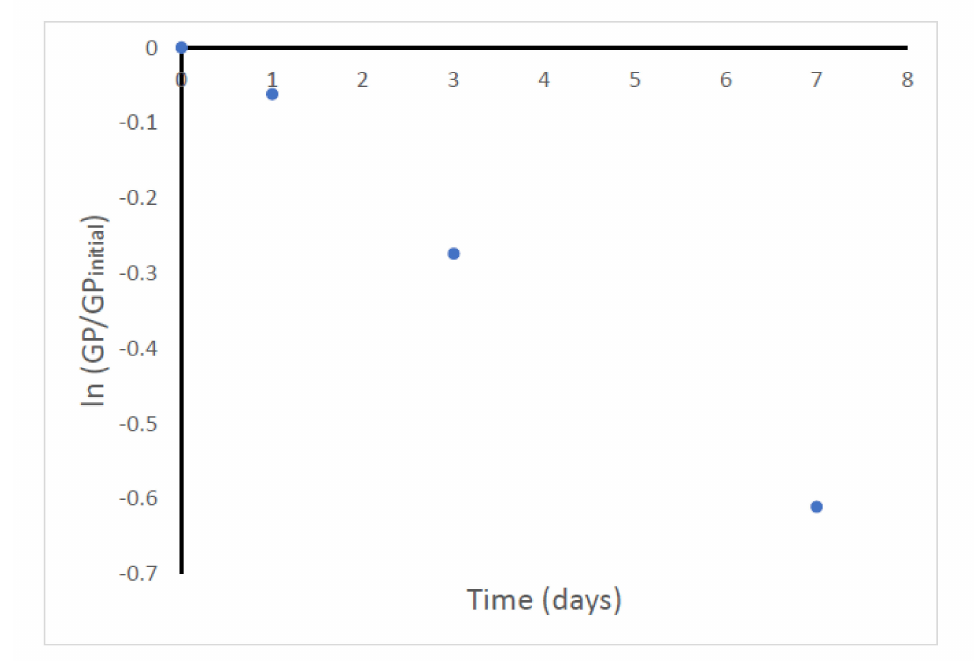
Figure 5. The decomposition rate of GP follows a first order rate law with a hydrolysis half-life of 7.8 days (R 2 =